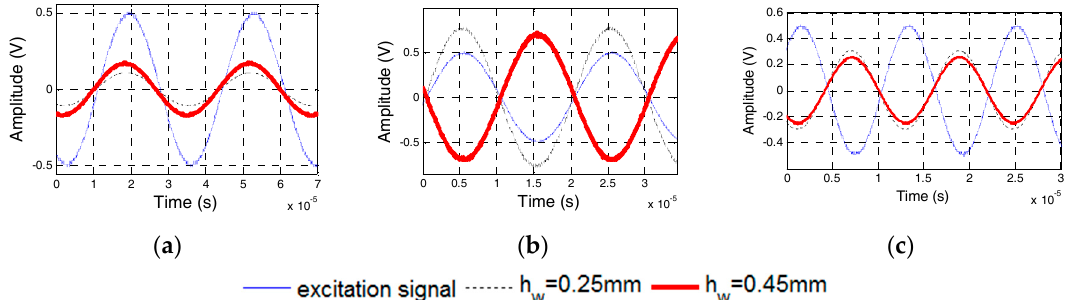
Figure 24. PZT transducer signals of Specimen 6. ( a ) 20 kHz Excitation Frequency; ( b ) 50 kHz Excitation Frequency; and ( c ) 65 kHz Excitation Frequency.